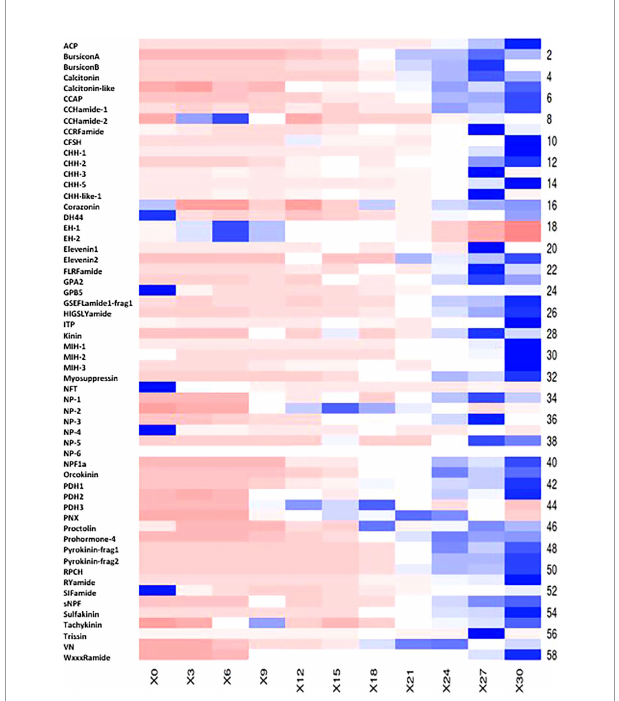
FIGURE 5 | Heatmap of 58 putative Panulirus ornatus neuropeptides across 11 stages of embryogenesis, generated using Heatmapper (Babicki et al., 2016). The intensity of the transcript expression, represented as RPKM are displayed as colours ranging from red (lowest expression) to blue (highest expression). X axis presents the stage of embryonal development, represented as days post-fertilization.